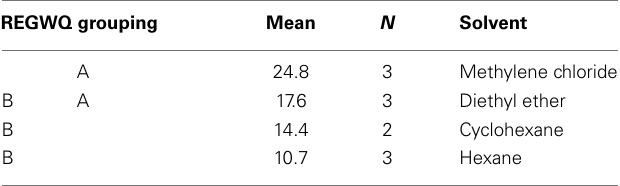
Table 3 | Ryan–Einot–Gabriel–Welsch post hoc comparison of lipid yields from extraction solvents